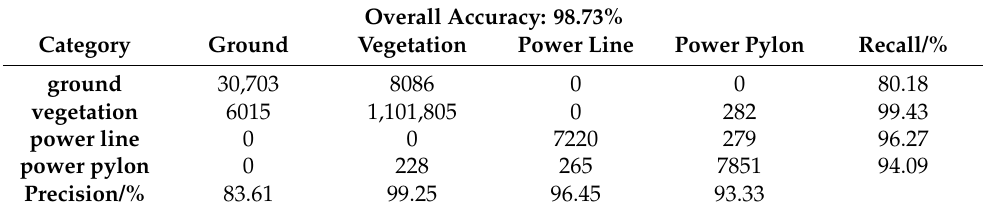
Table 3. Confusion matrix for classification of region B. Table 5. Comparative analysis of different classification methods.